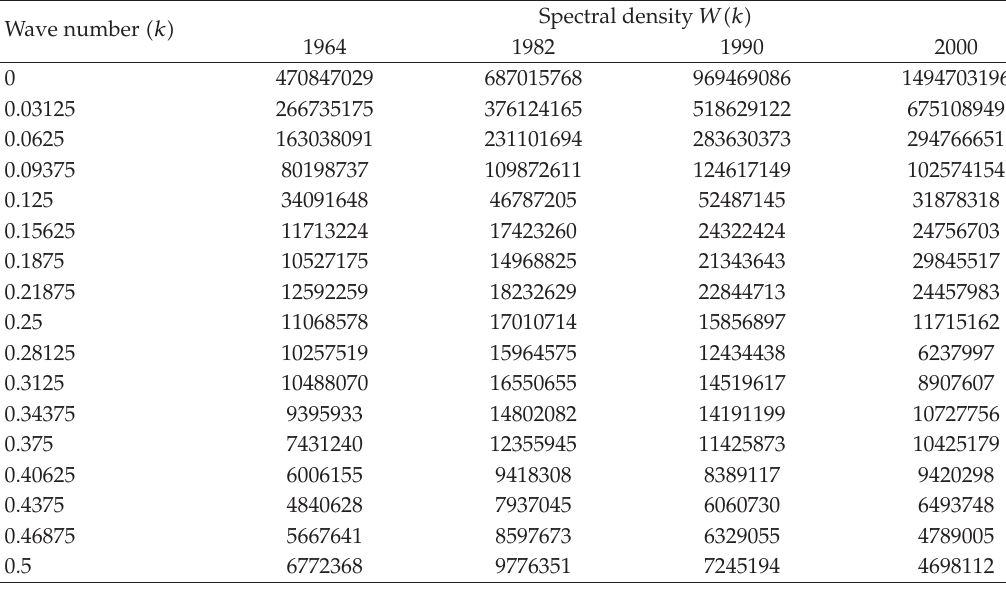
Spectral density W (cid:6) k